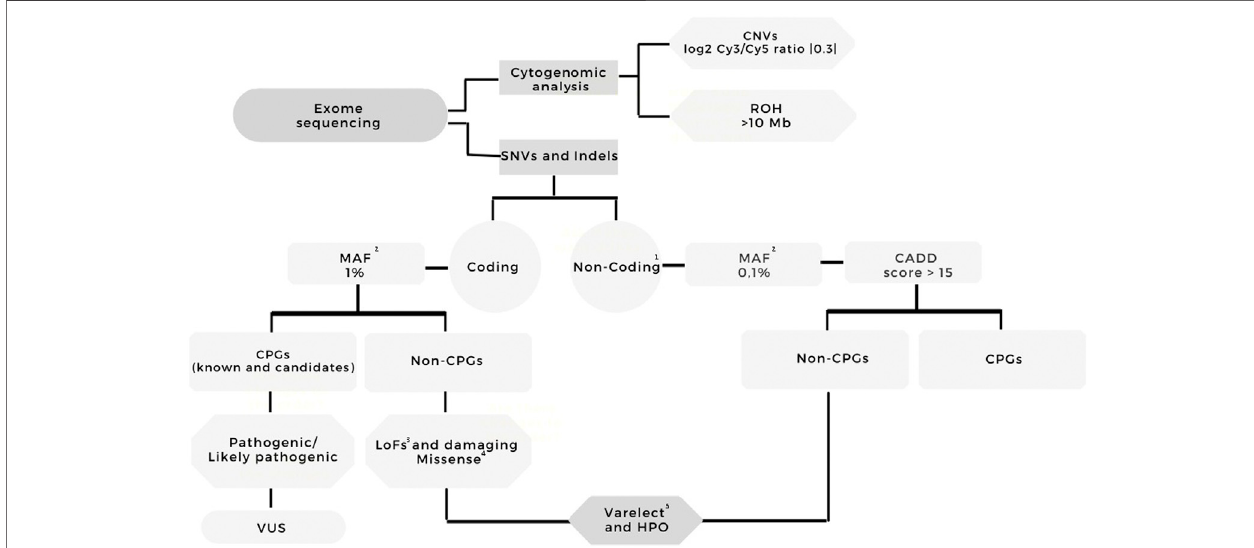
FIGURE 1 | Work fl ow of the exome sequencing analysis. Variants were fi ltered according to quality (Phred score > 20, read depth > 10, variant allele frequency > 35%);codingandnoncodingvariantswereseparatelyanalyzed;frequency(GnomAD,ABraOM,1KGenomes);theeffectoncodingvariants(frameshift,stoploss/gain, missense, splice site, nonsense); for missense variants, the prediction of pathogenicity in at least fi ve out of six algorithms; HPO annotation (hepatoblastoma, abnormalitiesoftheliver,andcancer).The fi lteredvariantswerevisuallyexaminedusingIntegrativeGenomicsViewer(IGV)software(http//www.broadinstitute.org/ igv) to further fi lter out possible strand bias and homopolymeric region artifacts. All the fi ltered variants mapped to cancer predisposition genes were classi fi ed using the ACMG guidelines. One- Intronic variants, 3 ′ UTR, 5 ′ UTR; two- MAF: GnomAD, ABraOM, 1K Genomes; three- Frameshift, stop loss, stop gain, missense, splice site, nonsensevariants;four-MissensevariantswithdbNSFPFunctionalPredictionofpathogenicityinatleast fi veoutofsixalgorithms; fi ve-TermsusedforVarelectandHPO annotation: Hepatoblastoma, abnormalities of the liver, and cancer. CNV — copy number variation, ROH - region of homozygosity, MAF — maximum allele frequency, CPG — cancer predisposition gene, VUS — variant of uncertain signi fi cance, HPO — Human Phenotype Ontology, HB — hepatoblastoma.